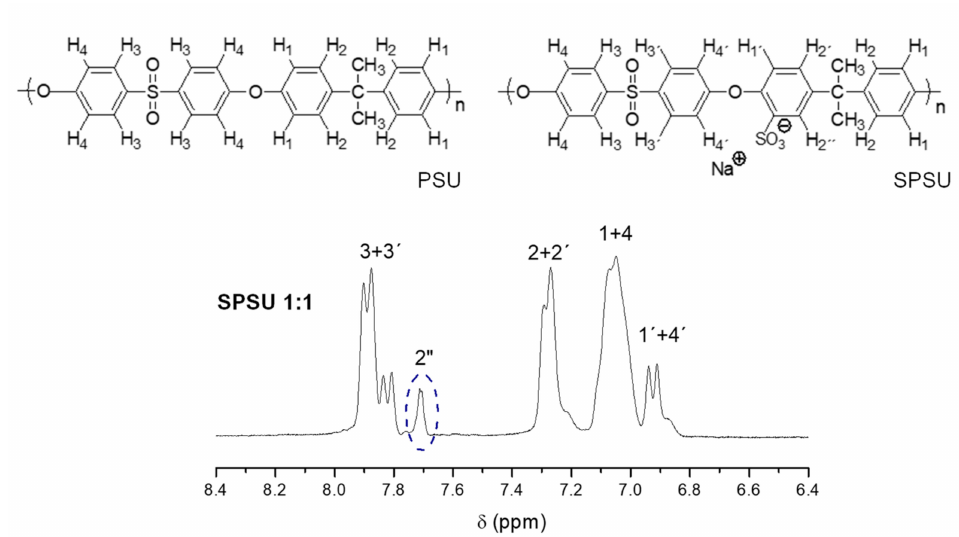
Figure 3. Proton nuclear magnetic resonance spectroscopy ( 1 H-NMR) spectrum of SPSU 1:1 (DMSO-d 6